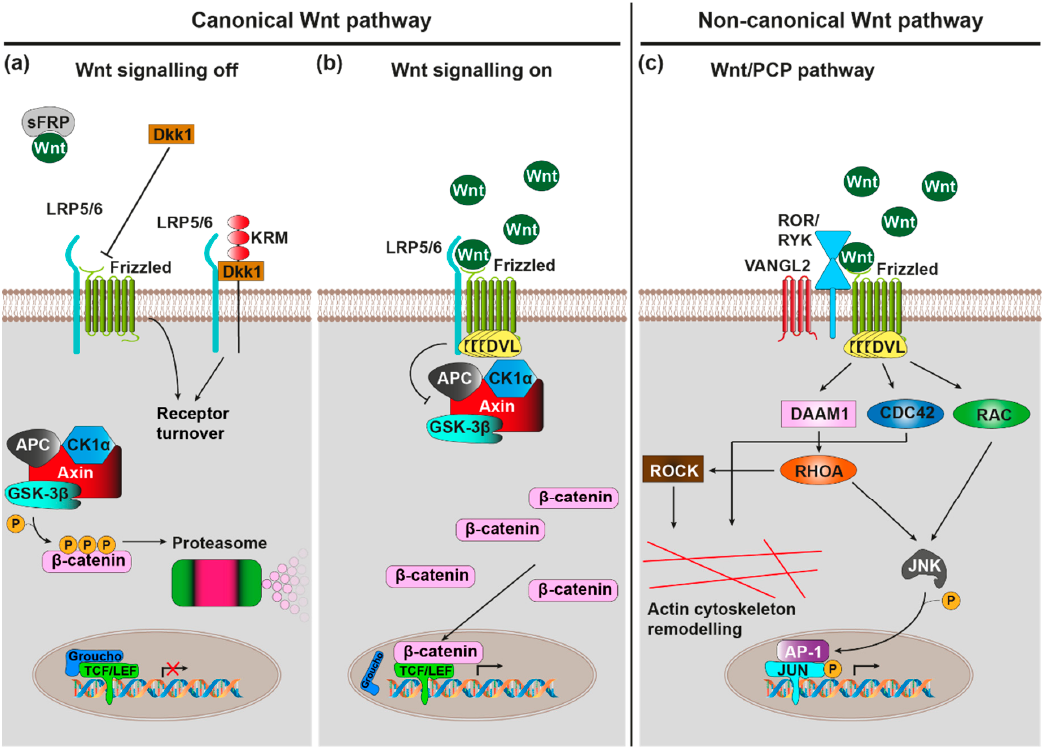
Figure 1. Wnt signalling pathways. Note that emphasis is placed on pathways and components that are of greater relevance in the context of AD. ( a ) Canonical Wnt signalling pathway, o ff : In absence of Wnt ligandbindingtoFrizzled(Fz)-LRP5 / 6heterodimericcellsurfacereceptors, theAxin / APC / CK1 α / GSK-3 β destruction complex phosphorylates the transcription factor β -catenin, marking it for proteasomal degradation. Endogenous canonical Wnt antagonists (including sFRP and Dkk1) further favour the ‘o ff ’ state. ( b ) Canonical Wnt signalling pathway, on: Wnt ligand binding to Fz-LRP5 / 6 recruits the sca ff olding protein DVL, which in turn inhibits GSK-3 β activity of the destruction complex. β -catenin subsequently accumulates in cytoplasm, allowing it to translocate to the nucleus where it transactivates the TCF / LEF-mediated expression of canonical Wnt target genes. ( c ) Wnt / planar cell polarity (PCP) pathway: Wnt ligand binding to Fz-ROR / RYK co-receptors recruits DVL, which in turn activates the small GTPases RHOA, RAC, and CDC42. RHOA and RAC conjointly activate JNK, which stimulates Jun transcription factor dependent gene expression via phosphorylation. Furthermore, RHOA, via ROCK, and CDC42 stimulate actin cytoskeleton